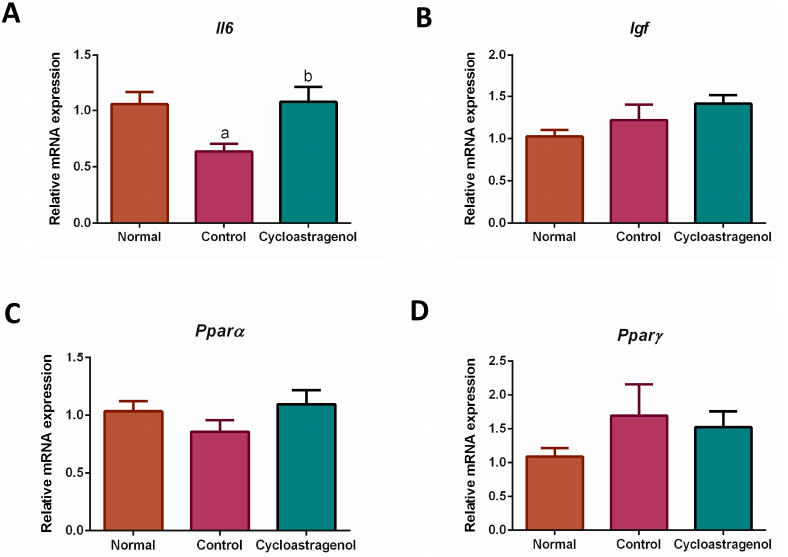
Figure 6. Effects of cycloastragenol (200 mg/kg) on the expression of gene-encoding markers associated with inflammation in the liver of mice treated with carbon-tetrachloride. Relative mRNA expression of interleukin 6 ( Il6 , ( A )), insulin-like growth factor ( Igf , ( B )), peroxisome proliferator-activated receptor alpha ( Ppar α , ( C )), and peroxisome proliferator-activated receptor gamma ( Ppar γ , ( D )) when compared with the normal is shown. Bar graphs and corresponding error bars indicate means and SEM among the same treatment, respectively ( n = 8–10). a and b indicate p < 0.05 when compared with the normal and control, respectively.